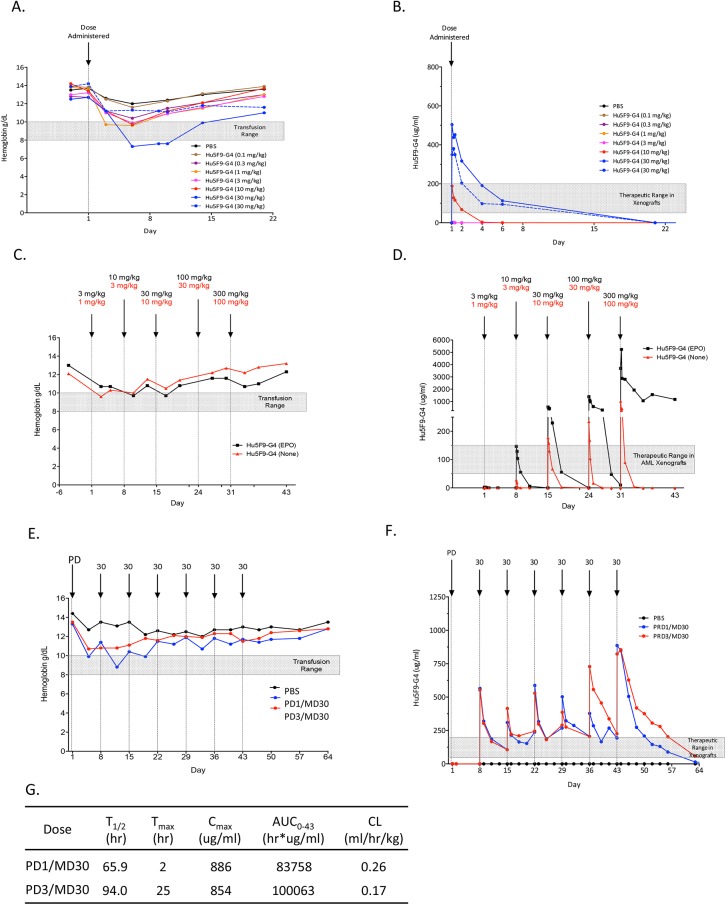
Non-human primate pharmacokinetic and toxicology studies show no serious adverse events associated with Hu5F9-G4.(A) Individual cynomolgus monkeys were administered single intravenous infusions of Hu5F9-G4 at the indicated doses. The hemoglobin level was monitored over 3 weeks. The shaded bar indicates the range of hemoglobin that might trigger transfusion in humans. (B) Serum Hu5F9-G4 levels were determined from the monkeys dosed in panel A. The shaded bar indicates the range of serum Hu5F9-G4 associated with efficacy against human cancer in xenograft studies. (C) Individual cynomolgus monkeys that received either no pre-treatment (red) or pre-treatment with a single dose of EPO (black) were administered Hu5F9-G4 in a dose escalation study with the doses and time points indicated. Hemoglobin was serially measured to monitor anemia. The shaded bar indicates the range of hemoglobin in humans that might trigger transfusion. (D) Serum Hu5F9-G4 levels were determined from the monkeys dosed in panel C. The shaded bar indicates the range of serum Hu5F9-G4 associated with potent efficacy against primary human AML in xenograft studies. (E) Cynomolgus monkeys were administered a priming dose (PD) on Day 1 of either 1 or 3 mg/kg, followed by once weekly maintenance doses (MD) of 30 mg/kg at the indicated time points. Hemoglobin was serially measured to monitor anemia, and the shaded bar indicates the range of hemoglobin in humans that might require transfusion. (F) Serum Hu5F9-G4 levels were determined from the monkeys dosed in panel E; the shaded bar indicates the range of serum Hu5F9-G4 associated with efficacy against human cancer in xenograft studies. (G) Pharmacokinetic parameters in cynomolgus monkeys dosed in panel E. T1/2: half-life, Tmax: time of Cmax, Cmax: maximum observed concentration, AUC: area under the curve, CL: clearance.